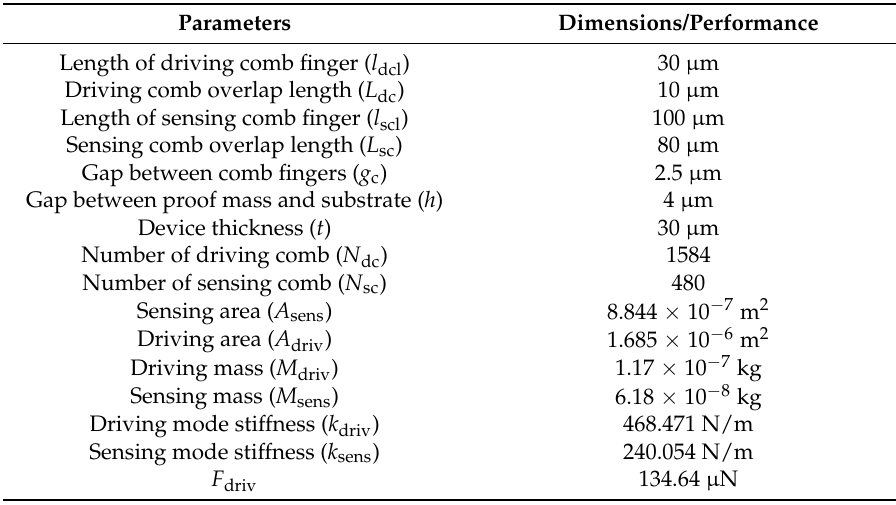
Table 1. Design parameters of the micro-gyroscope.